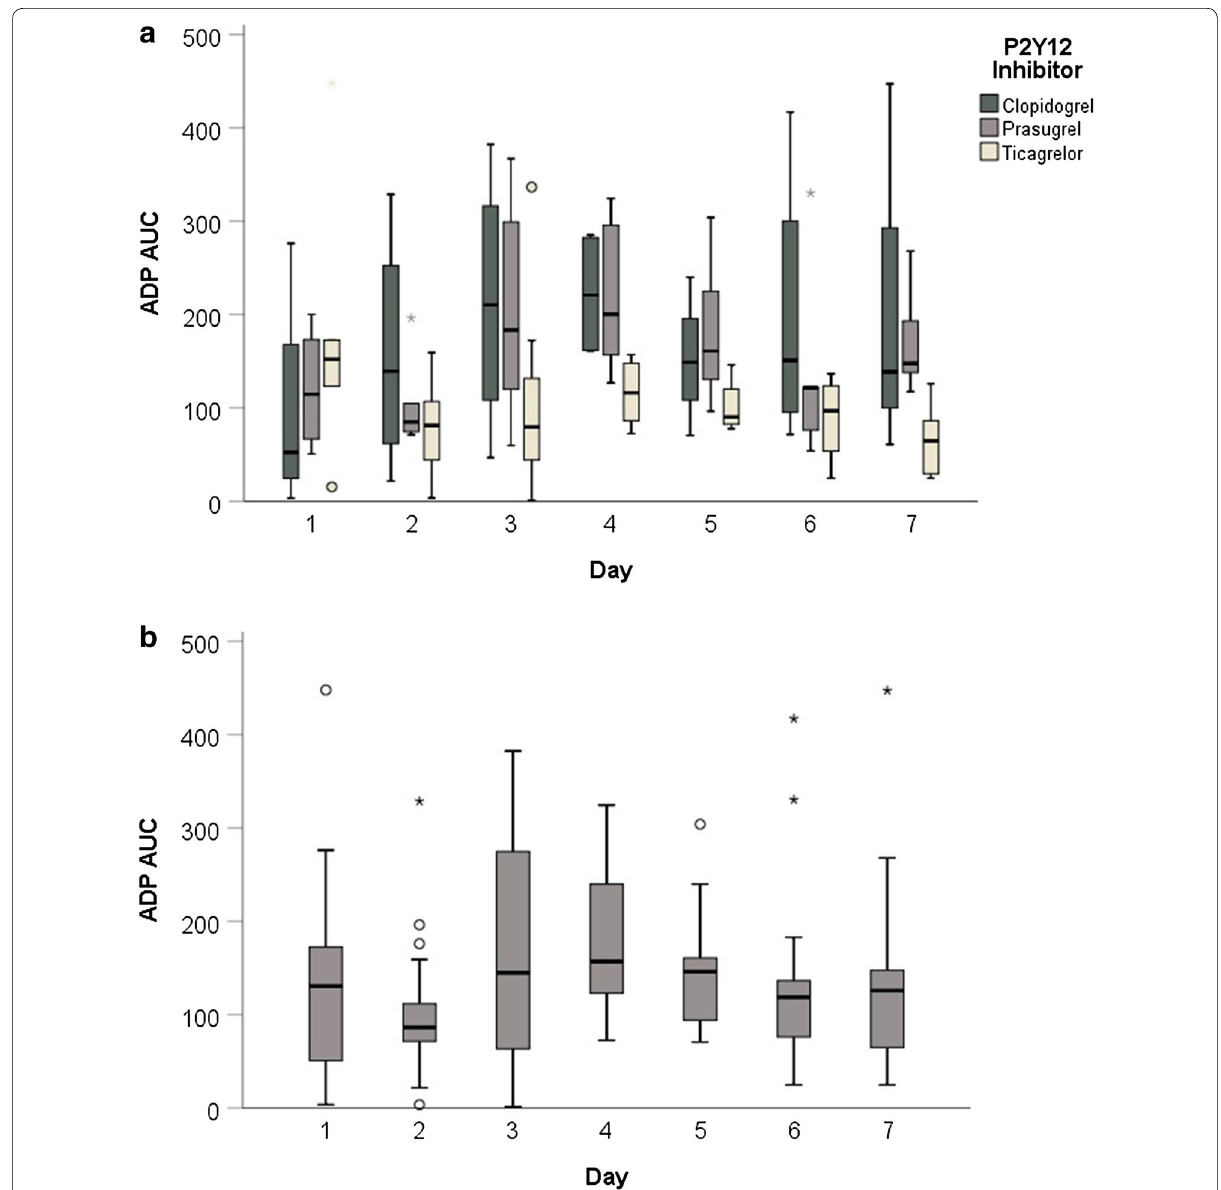
Fig. 3 Median ADP AUC for the first 7 days after admission. a Itemized by P2Y12 inhibitors. b For the entire study